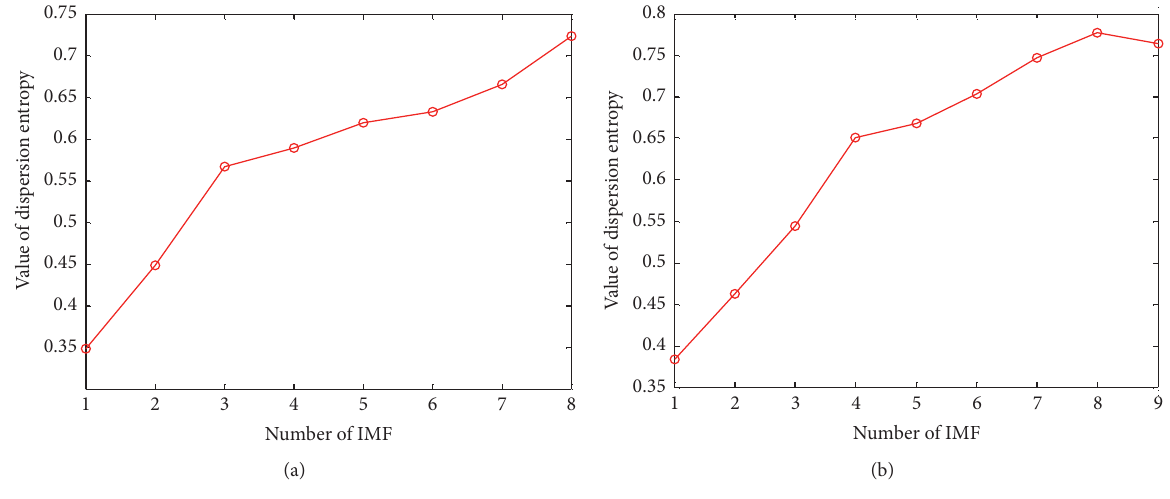
Figure 9: DE of each IMF sequences: (a) data set A; (b) data set Table 1: Recombined by the DE value of VMD subsequence of data set A.